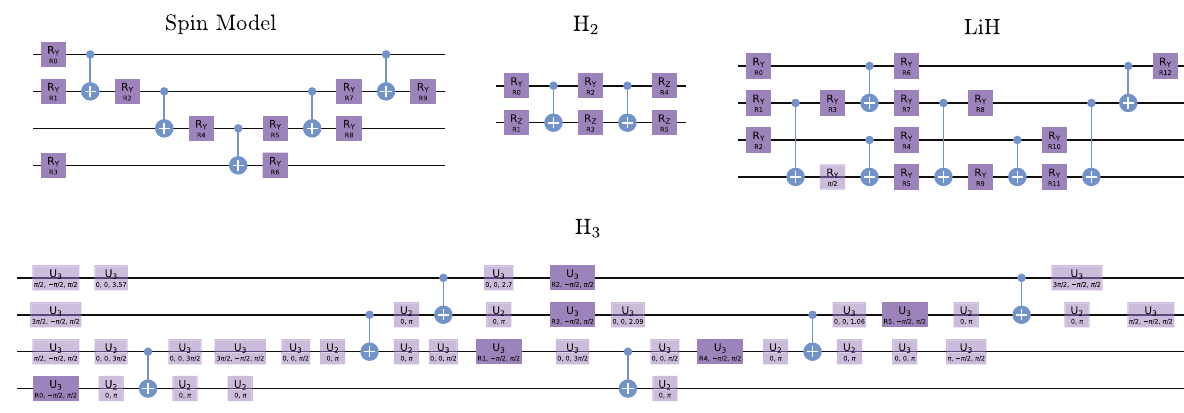
Fig. 5 Parameterised quantum circuits used as ansatz. Ansatz circuits used for each of the physical systems we consider, generated using the procedure described in “ Ansatz design ” . Gates referenced are from the Qiskit gate set 40 . Parameterised gates are shown in solid colours and fi xed angle rotations are indicated with partial